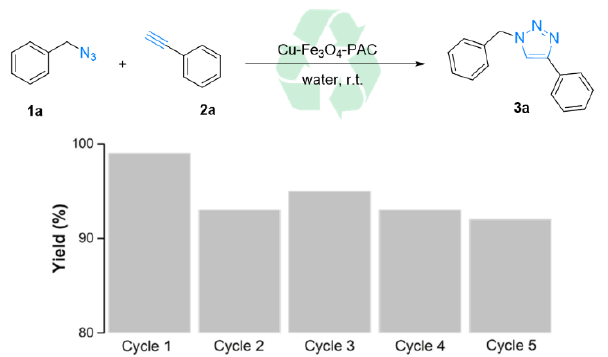
Figure 9. Yields of the Cu-Fe 3 O 4 -PAC catalyst in the cycloaddition of benzyl azide (1a) and phe- nylacetylene (2a) after five cycles of recovery/reuse.